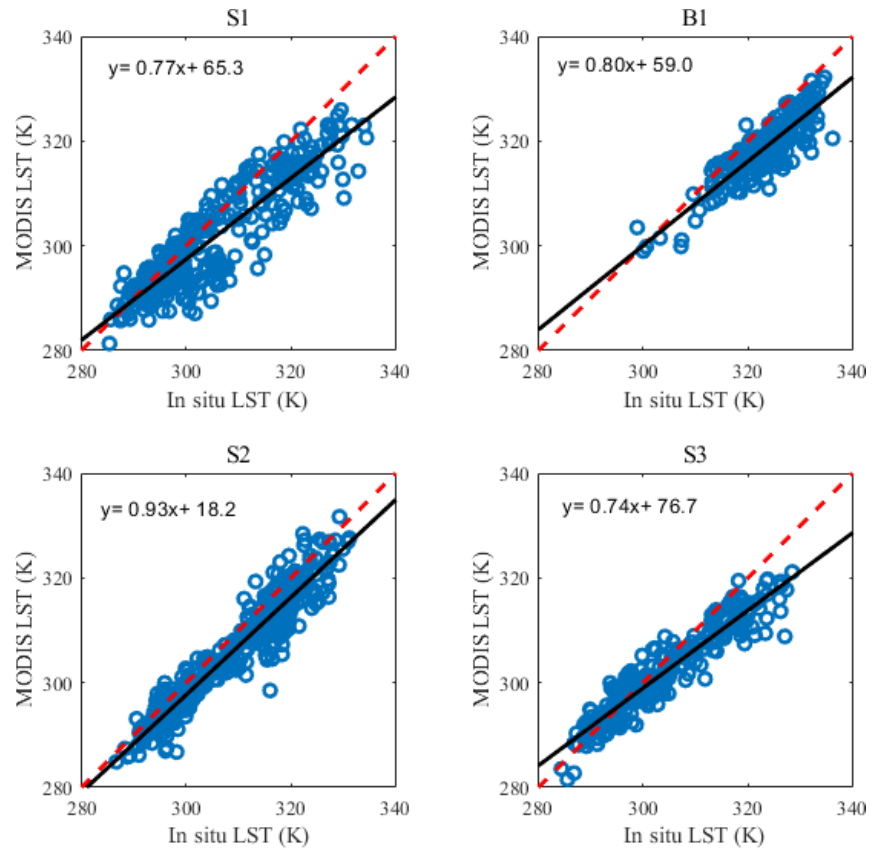
Figure 2. Scatterplots of MODIS versus in situ LST at the Sidi Rahal site for the S1 (2014–2015), B1 (2015–2016), S2 (2016–2017) and S3 (2017–2018) agricultural seasons, separately, (red dashed line is the 1 : 1 line; black line is the regression line).